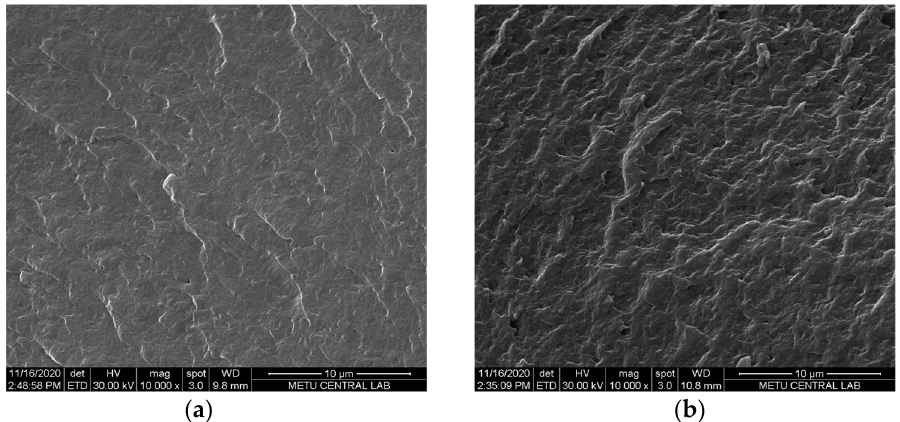
Figure 4. Morphology of the cross-section of ( a ) PECH-H and ( b ) PECH-C type membranes (magnification: 10,000×).